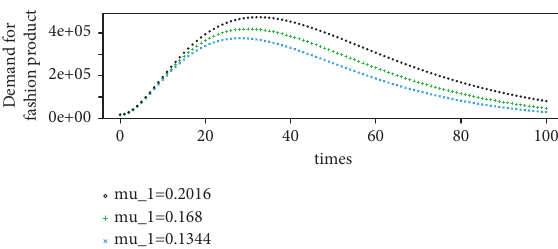
Figure 8: Simulation of demand for fashion products at three different rates (0.134, 0.168, and 0.2016) of μ fashion products shifts outward from the origin (left) to the right.